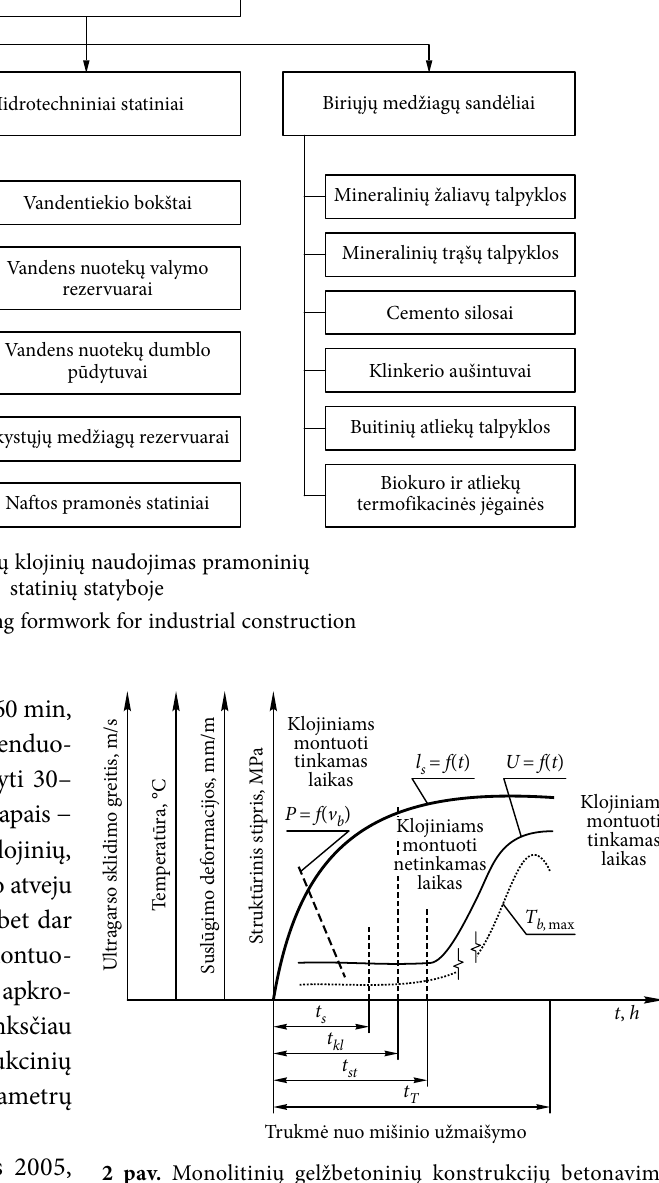
2 pav. Monolitinių gelžbetoninių konstrukcijų betonavimo – betono mišinio pakloji- technologijos parametrų sąveika: t s – betono mišinio klodų intensyvaus mo sluoksniais trukmė; t kl – pakloto ir sutankinto betono struktūros slūgimo trukmė; t st – temperatūros betone intensyvaus formavimosi pradžia; T b ,max kitimo kreivė Fig. 2. Interaction of concreting technology parameters for monolithic reinforced concrete